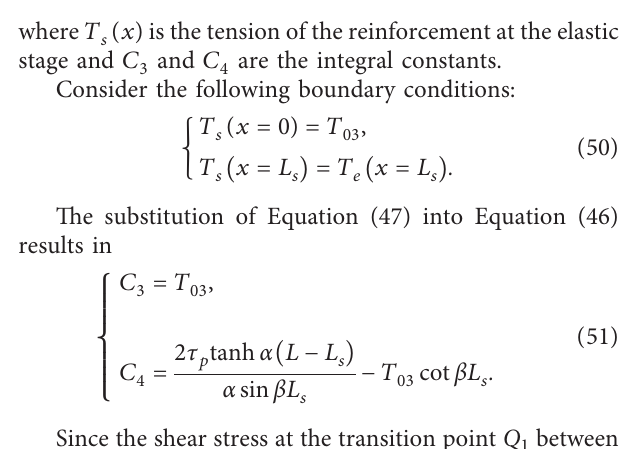
Figure 18: The progressive pull-out process of strain-softening reinforcement in the pull-out model analysis: (a) elastic stage; (b) elastic- softening transition stage; (c) pure softening stage; (d) softening-residual transition stage; and (e) pure residual